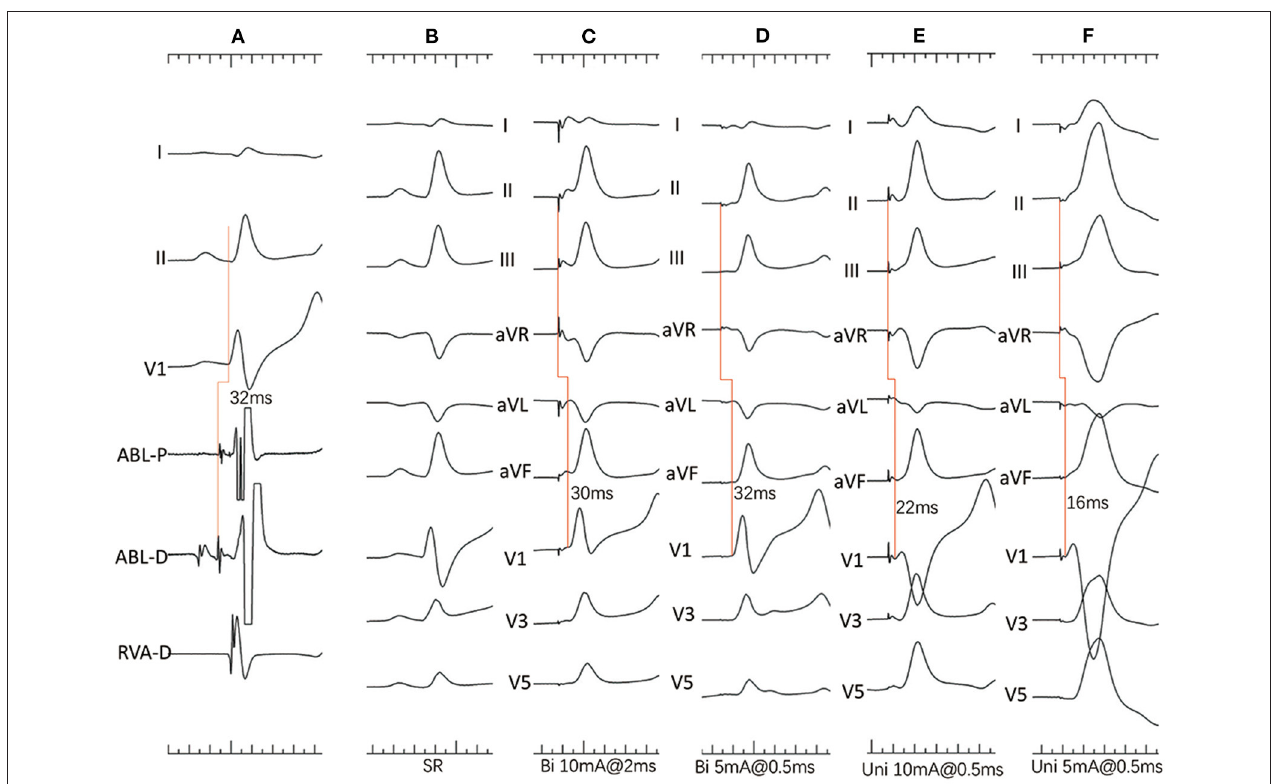
FIGURE 2 | (A–F) Dog #2 (group 2). (A) Surface ECG leads I, II, V1, and intracardiac recordings from a quadrupolar catheter in the right ventricle and mapping catheter (ABL) at the apex of the NCC-RCC junction. Note that the H-V interval is 30ms with atrial and His activation on distal electrodes. (B) Surface 12-lead ECG during sinus rhythm (SR). (C) Bipolar pacing with 10mA, 2ms shows slightly different morphology from SR with narrow QRS duration, indicating both myocardial and His capture. (D) Bipolar pacing with 5mA, 0.5ms shows paced QRS morphology identical to that during SR and a long stimulus to QRS interval indicating pure HB capture. (E) Unipolar pacing with 10mA, 0.5ms shows narrow QRS complexes with short stimulus-to-QRS interval, indicating both myocardial and His capture. (F) Unipolar pacing with 5mA, 0.5ms shows wide QRS complexes indicating only myocardial